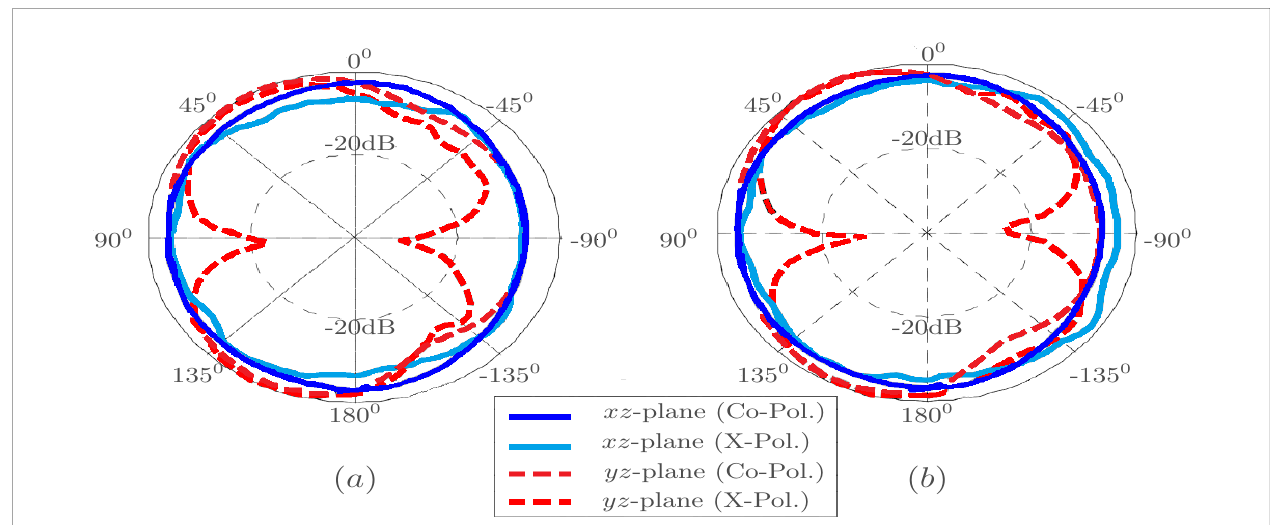
FIGURE 7: The measured far-field co-polarization and cross-polarization radiation pattern of the proposed MIMO UWB CPW -fed bent antenna ( a ) at 3 . 5 GHz ( b ) at 10 . 6 GHz